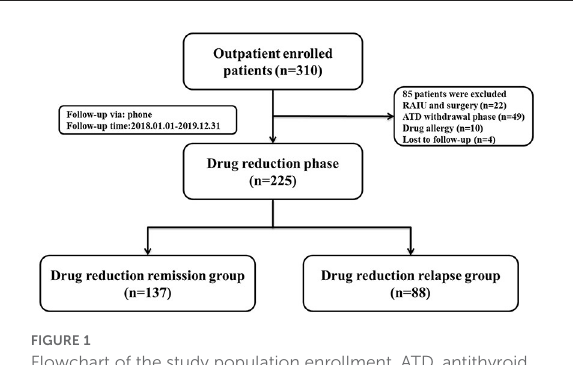
FIGURE1 Flowchart of the study population enrollment. ATD, antithyroid drug; RAIU, radioactive iodine ablation.